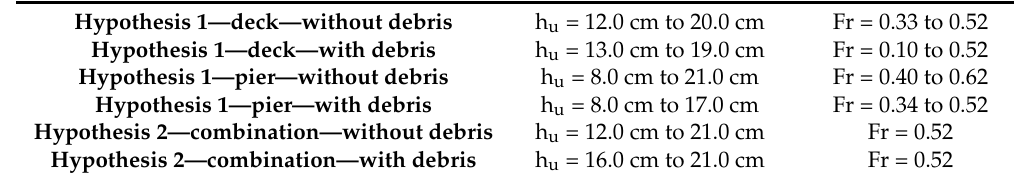
Figure 9. Self-weight restoring moment of the deck-pier system (about the heel of the pier) minus the hydrodynamic overturning moment, as measured by the load cell.